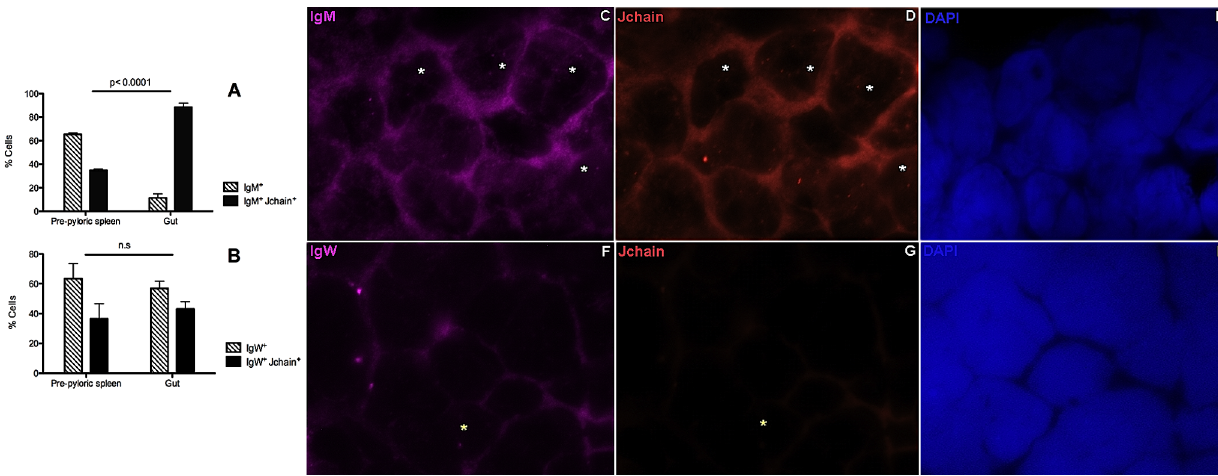
Figure 4. Expression of J chain by B cells of Nigerian spotted lungfish ( P.dolloi ). A) Mean percentage of IgM + and IgM + J chain + B cells and B) Mean percentage of IgW + and IgW + J chain + B cells in the pre-pyloric spleen and gut of control P. dolloi (n=3) studied by double FISH staining. Cells were counted from 20 different fields ( 6 60). Differences were statistically significant when p , 0.05. n.s: non-significant differences. C–E) Examples of representative FISH staining showing IgM + J chain + lymphocytes (white asterisks) from a gut cryosection. C) Cy5-IgM FISH probe D) Cy3- Jchain FISH probe E) DAPI nuclear stain. F–H) Examples of representative FISH staining showing a IgW + J chain 2 lymphocyte (yellow asterisk) from a pre-pyloric spleen cryosection. F) Cy5-IgW FISH probe G) Cy3-Jchain FISH probe H) DAPI nuclear stain.